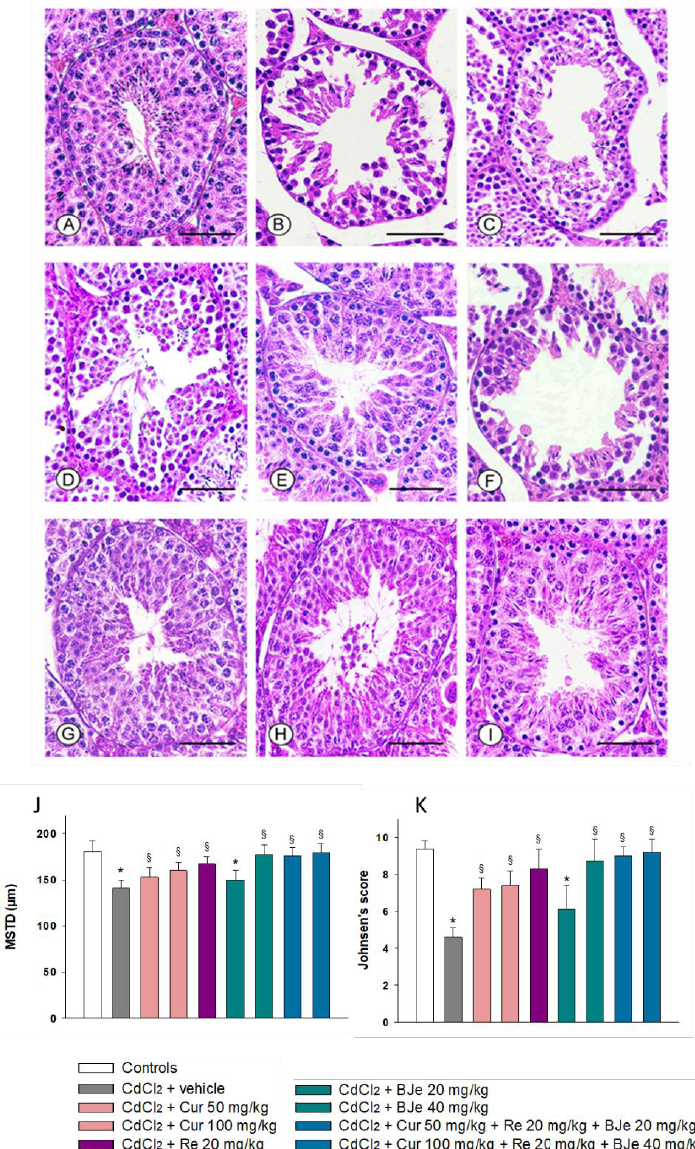
Figure 3. Histological organization of the testes evaluated with hematoxylin–eosin stain in different groups of adult male mice (7 mice/group) (scale bar: 50 µm). ( A ): Control mice. The normal structure of both tubular and extratubular compartments is present. ( B ): Mice challenged with CdCl 2 . Testes with discontinuous epithelium and marked edema in the extratubular compartment are present. ( C , D ): Mice challenged with CdCl 2 and treated with Cur at 50 or 100 mg/kg. Tubules with seminiferous epithelium formed by spermatocytes separated from spermatogonia are evident. ( E ): Testes of CdCl 2 plus Re-treated mice. Significantly larger tubules with elongated spermatids can be observed. Extratubular edema is reduced. ( F ): Testes of CdCl 2 plus BJe at 20 mg/kg-treated mice. The germinal epithelium shows many large clefts and many irregularly arranged spermatocytes. Hyperemia is present in the extratubular compartment. ( G – I ): Testes from mice treated with CdCl 2 plus BJe alone at 40 mg/kg and with both the extract associations Cur 50 mg/kg + Re 20 mg/kg + BJe 20 mg/kg and Cur 100 mg/kg + Re 20 mg/kg + BJe 40 mg/kg. In all groups, the germinal epithelium has a normal structure with many spermatids and mature spermatozoa. Additionally, the extratubular compartment shows normal morphological organization. The images are representative of the nine mice from each experimental group. ( J ): Quantitative evaluation of the mean tubular diameter in the different groups of mice. ( K ): Johnsen’s score in the different groups of mice. * p < 0.05 versus control; § p < 0.05 versus CdCl 2 -treated